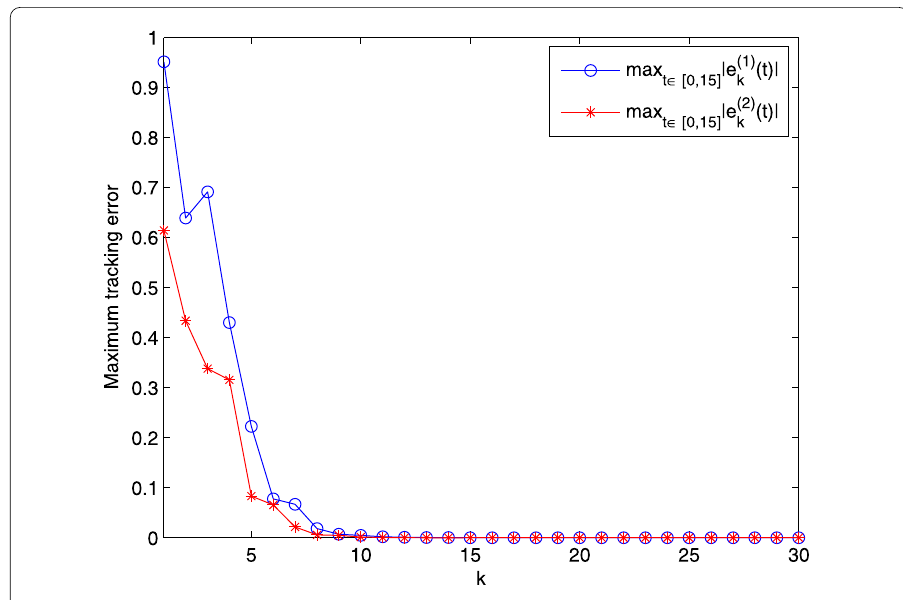
Figure 6 The maximum tracking error versus iteration